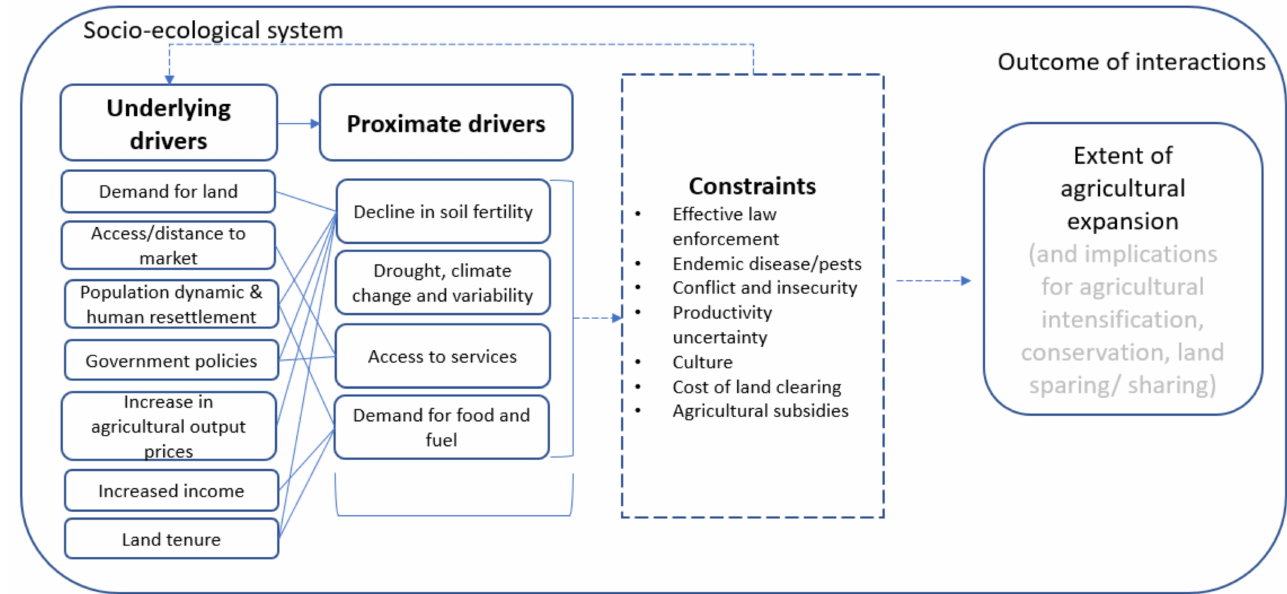
Figure 3. Interactions among underlying, proximate drivers of agricultural expansion and constraints based on the systematic review. Implications in